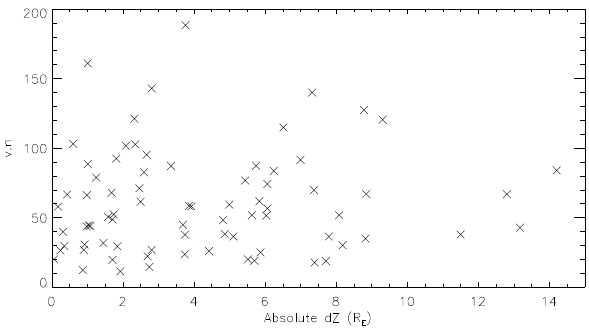
Fig. 19. The normal velocity component plotted against distance from the neutral sheet modelled by Dandouras (1988) for plasma sheet expansions. The variability of the normal velocity component with dZ suggests that the velocity at which the boundary moves is sustained, or is not decelerated, after its initial acceleration.